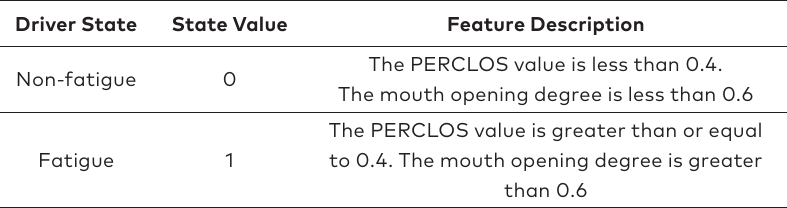
Table 2. Driver state